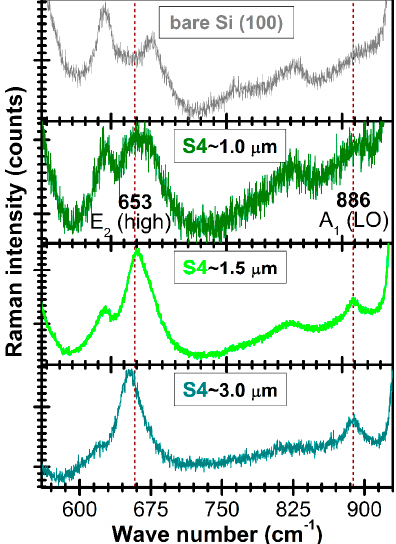
Figure 5. Comparative micro-Raman spectra of the S4—AlN/Si samples (with different film thicknesses) and of the bare Si substrate.